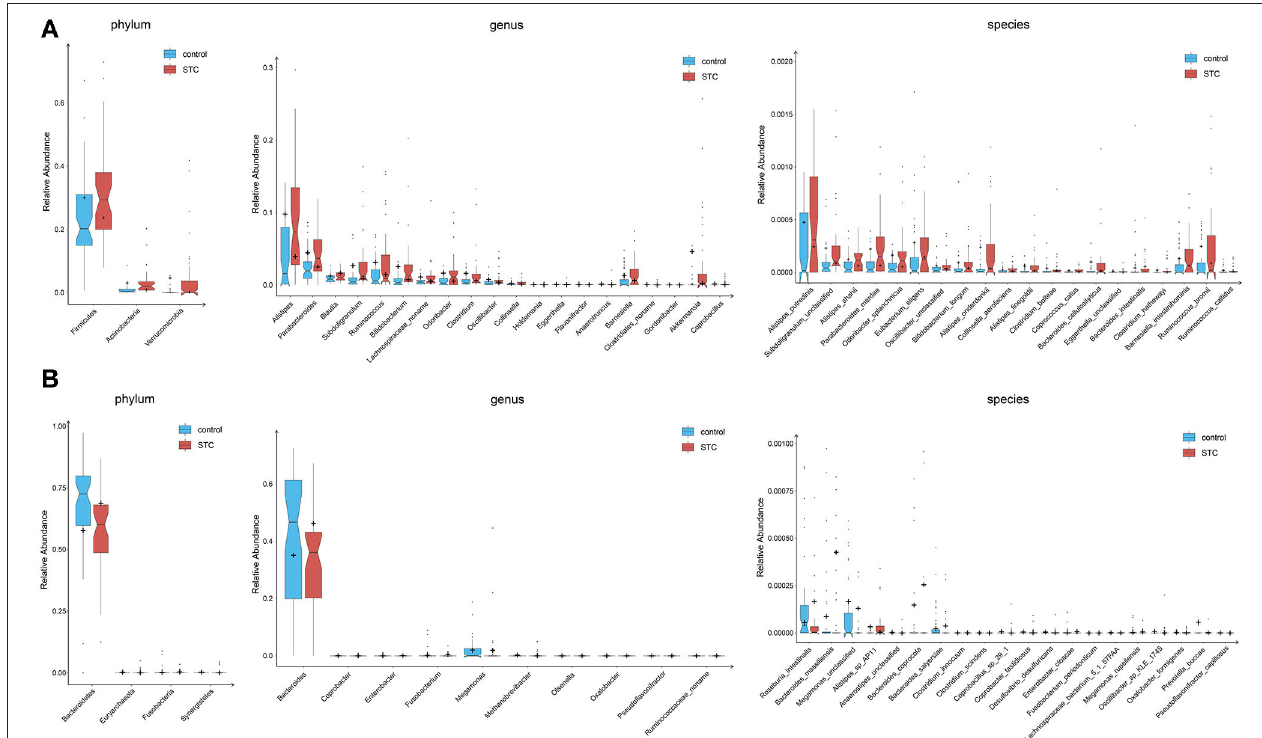
FIGURE 1 | Differences of phylogenetic abundance between patients with slow transit constipation (STC) and healthy controls. The phylotypes were increased (A) or decreased (B) in patients with STC at the phylum, genus, and species levels. Red and blue indicate patients with STC and healthy controls, respectively. The phylogenetic abundance of phyla that had mean values < 1% and that of genera and species that were < 0.01% was excluded. After exclusion, the Wilcoxon rank-sum tests were applied to identify the differentially abundant phyla, genera, and species. Among these, the highest medians of the phylogenetic abundance in the enriched cohort were drawn as